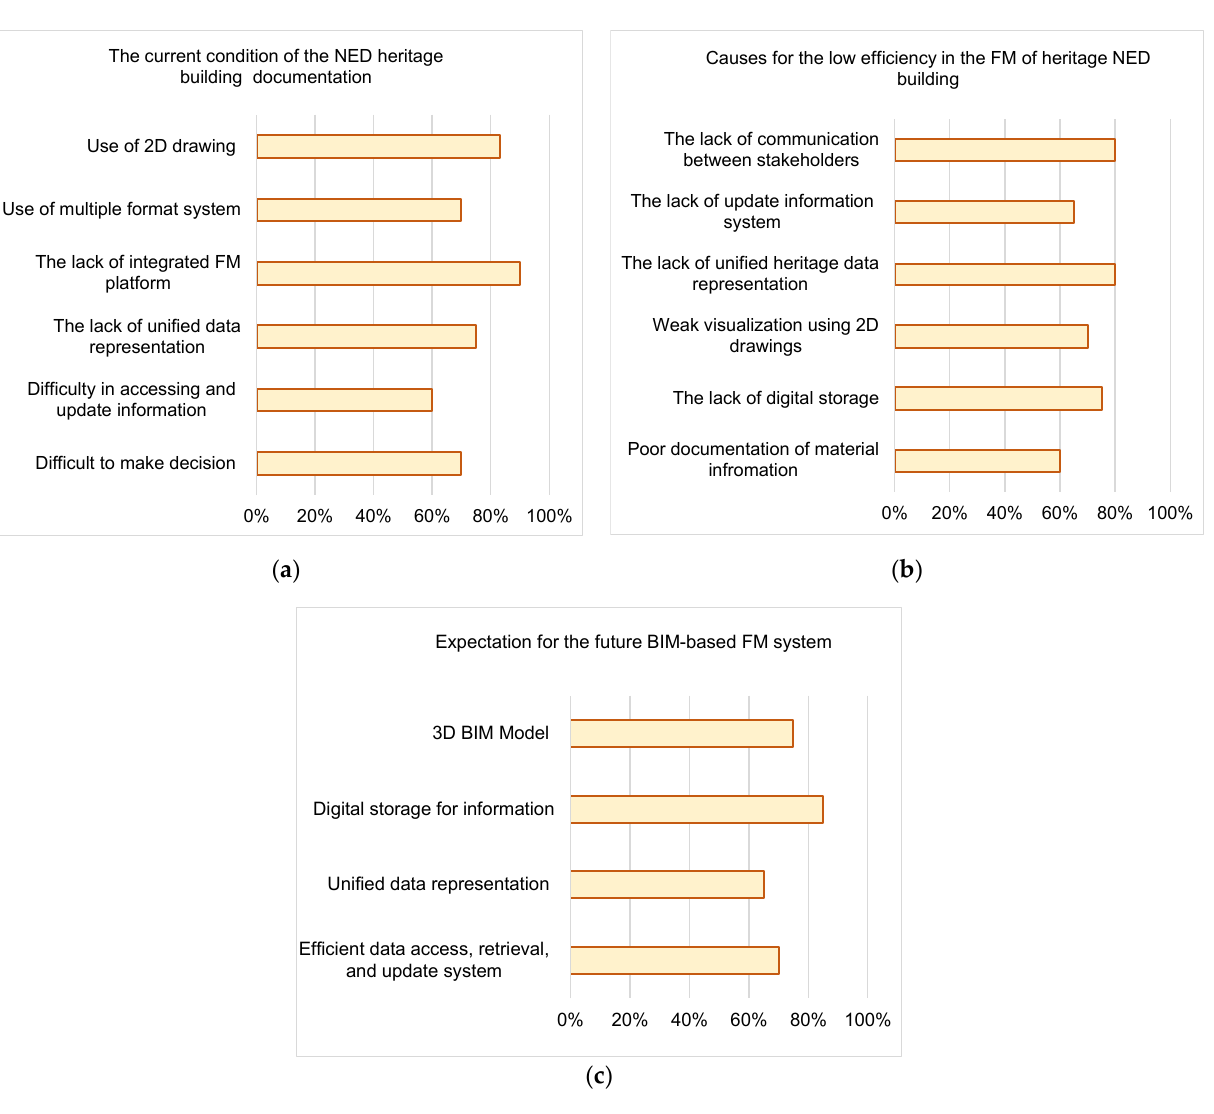
Figure 10. Part of the survey results; ( a ) The current condition of NED heritage building documentation; ( b ) reasons for inefficient NED heritage FM activities; and ( c ) expectation from proposed system.